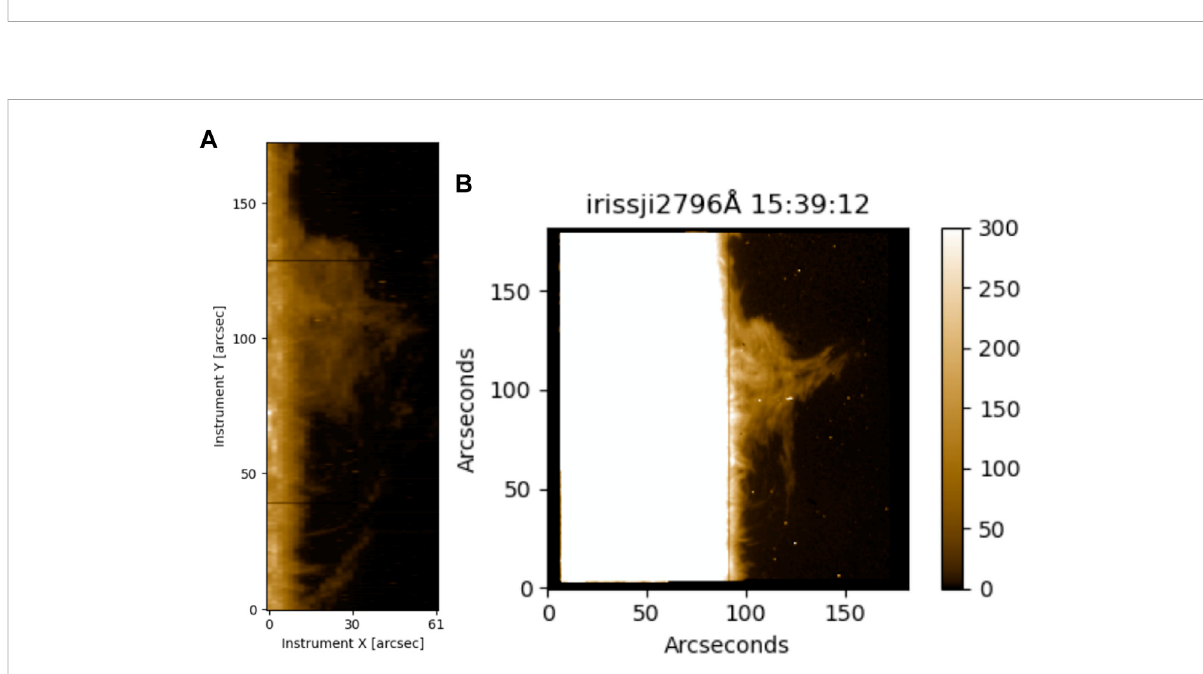
FIGURE 9 IRISobservationsoftheALMAprominence:rasteroftheMgIIhlineintensitytakenat14:14UT (A) andslit-jawimageat2796 Å (B) .Adaptedfrom Peat et al.